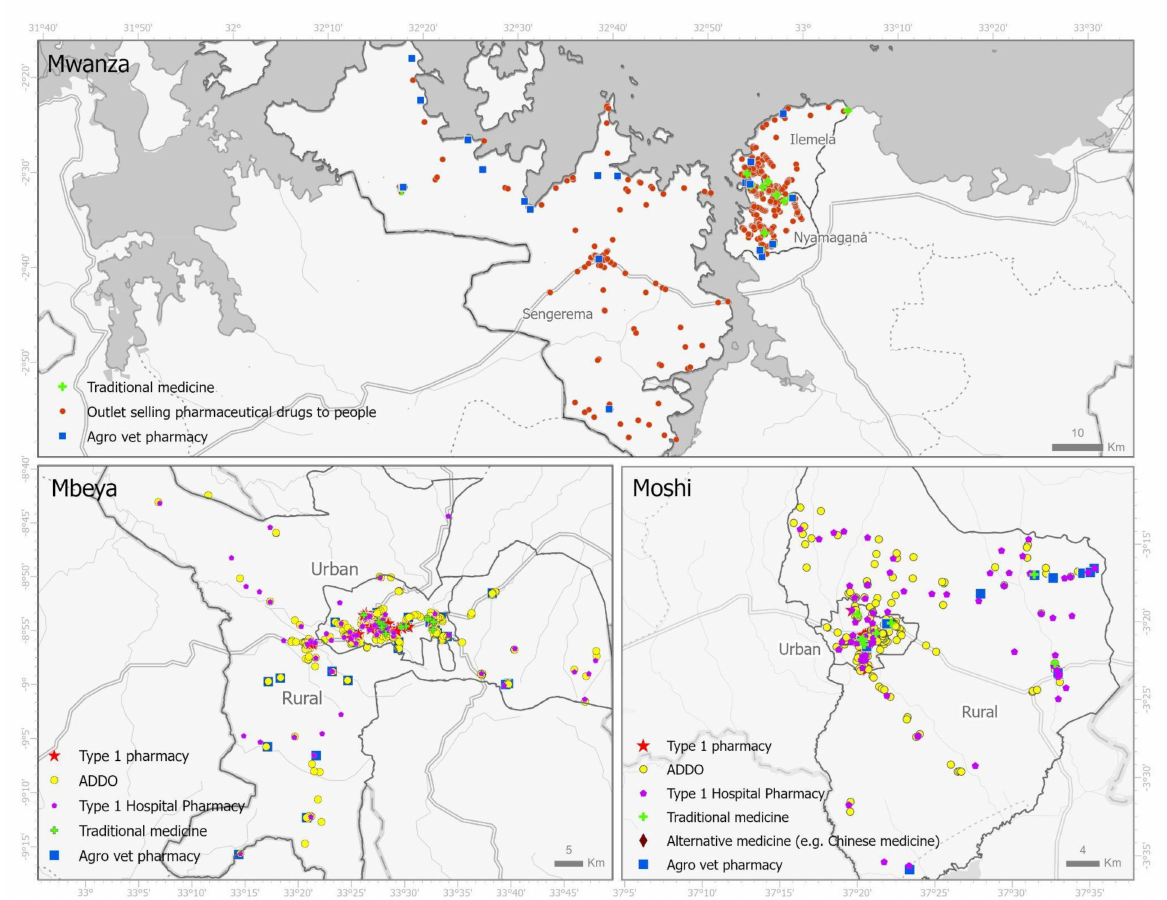
Figure 2. Geographical distribution of ADDOs, pharmacies and other drug providers mapped in the three study areas. ADDOs and pharmacies were surveyed in the mystery client